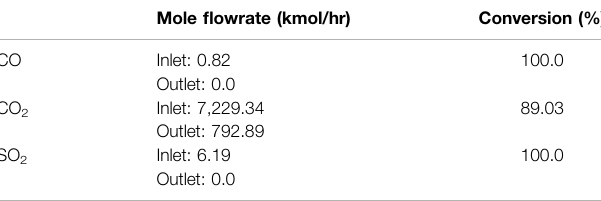
TABLE 3 | Reaction conversions in the carbonator reactor (single process line).